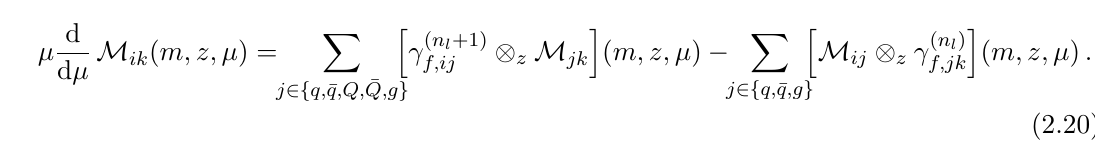
Figure 4 . Relevant modes for the q T spectrum with q T quark mass m and the scales q T and Q . The arrows indicate the relations between the modes and their associated